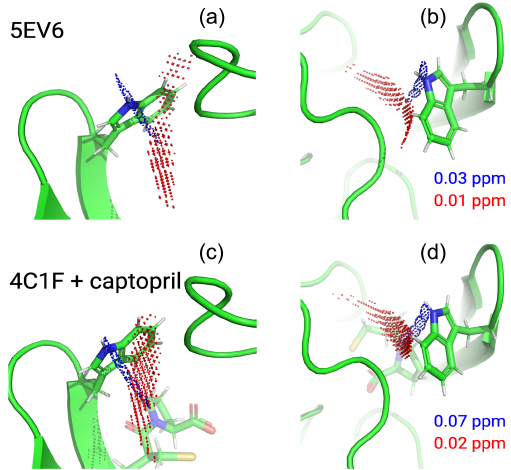
Figure 6. Localisation space of the side chain of Trp28 defined by the PCSs from tags in IMP-1 mutants A53C, N172C and S204C. The left and right panels display the same results in two different orientations. Red and blue points outline localisation spaces deter- mined for the H ζ 2 and H ε 1 atoms, respectively. The localisation space of the H ζ 2 atom was defined by the PCSs and (cid:49)χ tensors de- termined for the Tb 3 + -loaded C2 tags, while the localisation space of the H ε 1 atom was restricted by additional data obtained with the C12-Tb 3 + tag at site N172C. The boundaries of the respective lo- calisation spaces displayed are defined by the PCS RMSD values indicated in parts per million. The top panel depicts the localisa- tion spaces determined for the free protein plotted on chain A of the crystal structure 5EV6 depicted in two different orientations. The lower panel depicts the localisation spaces determined in the pres- ence of captopril plotted on chain A of the crystal structure